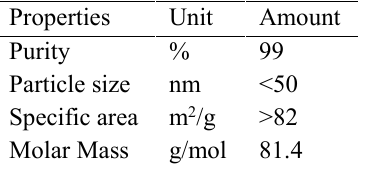
Table 3. Selected physical properties of Zn oxide nanoparticles in